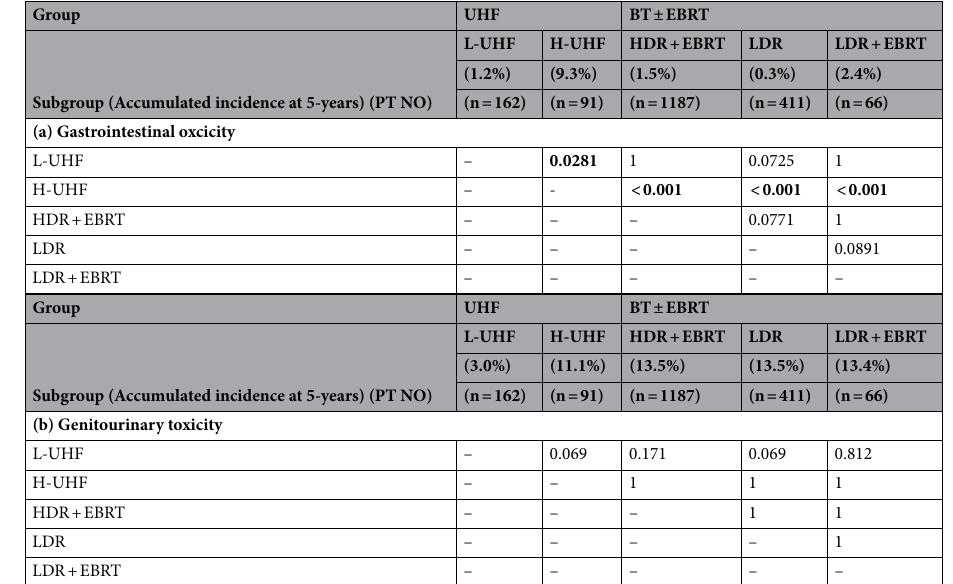
Table 5. Toxicity comparison among subgroup Patients characteristics between and BT with or without external beam radiotherapy. Bold values indicate statistically significance. BT brachytherapy, HDR high-dose- rate, LDR low-dose-rate, EBRT external beam radiotherapy, UHF ultrahypofractionated radiotherapy, L-UHF low dose UHF EQD2 < 100 Gy1.5 (α/β = 1.5), H-UHF high dose UHF EQD2 ≥ 100 Gy1.5 (α/β = 1.5). * p -value was calculated between UHF and BT ± EBRT.